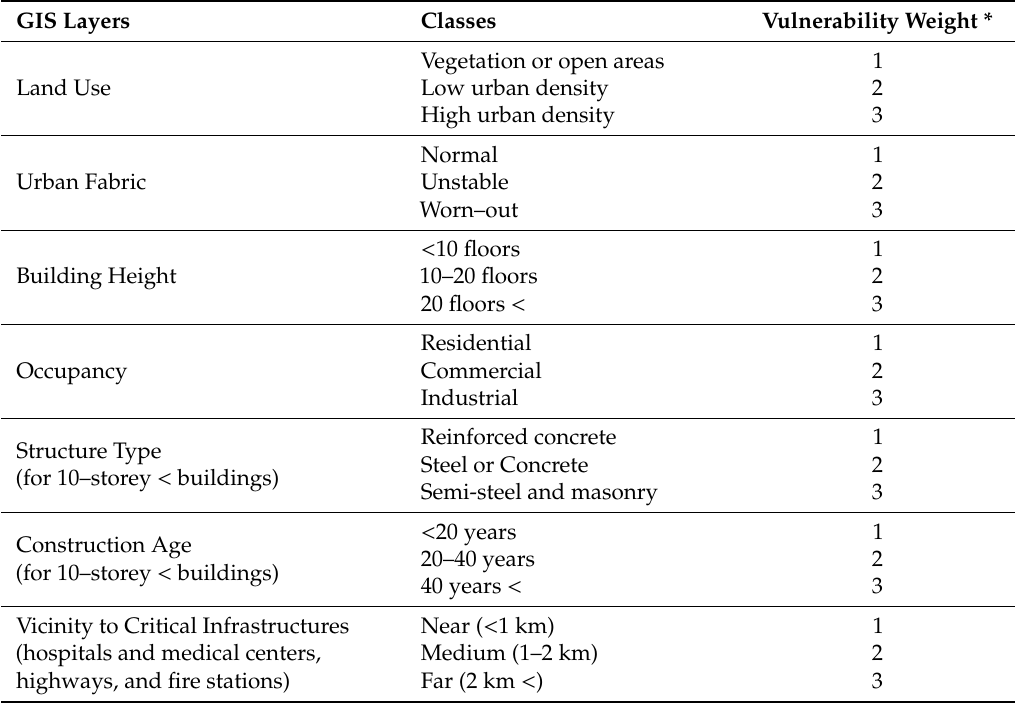
Table 3. Classification of physical vulnerability components in this